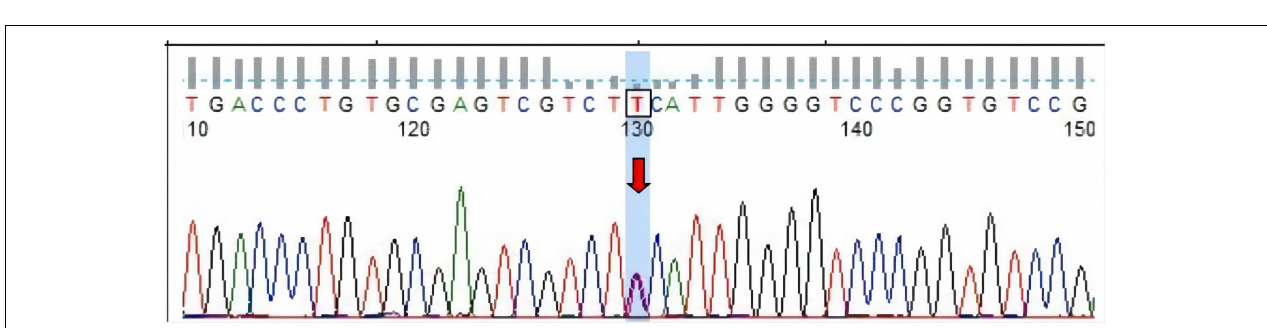
four-limb nerve demyelination with axonal damage, mainly at the distal end of the peripheral nerves [the median nerve, tibial nerve, and common peroneal nerve with bilateral reduced motor NCV (MNCV) and decreased amplitude; the ulnar nerve with bilateral reduced MNCV and decreased right amplitude; the median nerve, ulnar nerve, and superficial peroneal nerve with bilateral reduced sensory NCV and decreased amplitude, Table 1 ]. The CSF cell count was normal, but CSF protein